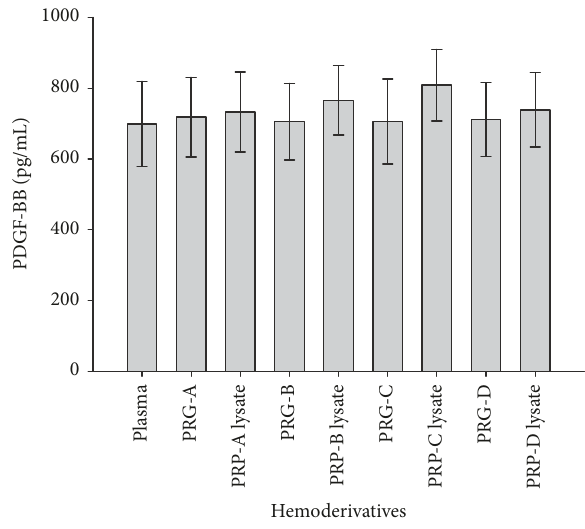
Figure 7: Mean ( ± SD) of PDGF-BB concentration (pg/mL) in plasma and four bovine PRG supernatants (A, B, C, and D) and their respective PRP lysates (A, B, C, and